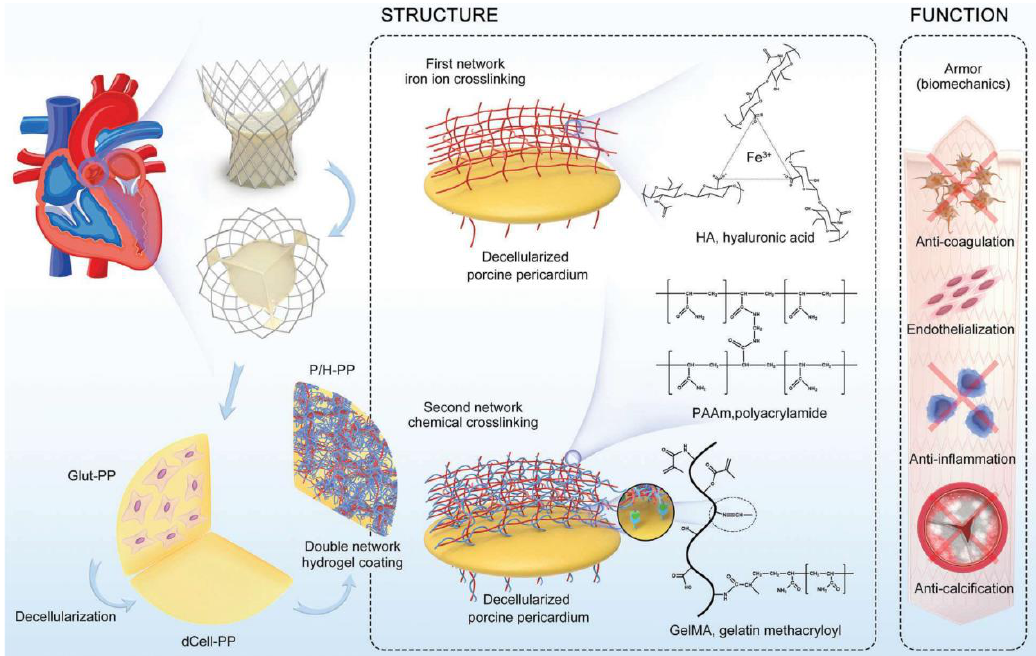
Figure 3. A schematic overview presenting the fabrication process, structure, and function of the decellularized porcine pericardium coated with polyacrylamide/hyaluronic acid dual-network hy- drogel (adapted from Ref. [84]).